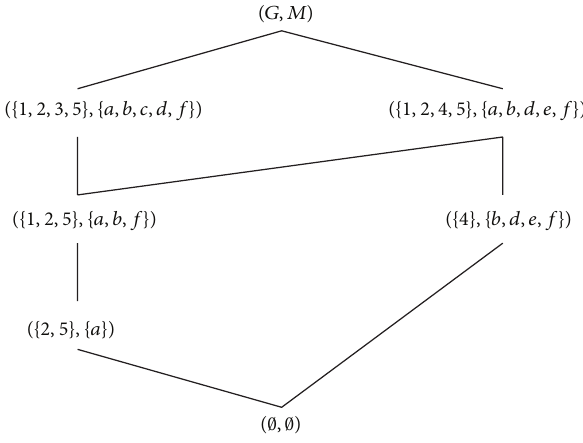
Figure 3: The Hasse diagram of B 𝑃 (𝐺,𝑀, 𝐼)